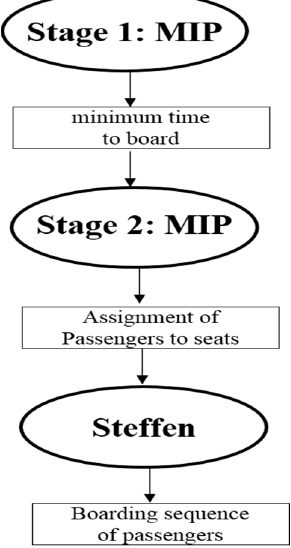
Figure 1. Proposed method, with two sequential MIPs, followed by Steffen.